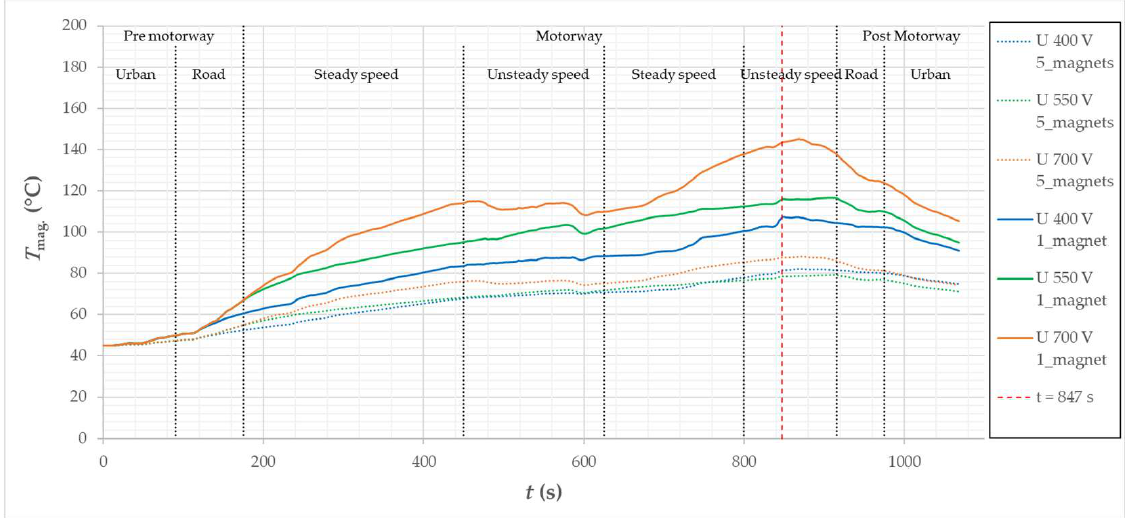
Figure 41. Calculated temperature waveforms of permanent magnets for three different supply voltages of the U DC drive, for a motor with magnet segmentation ( × ) and a motor without magnet segmentation.